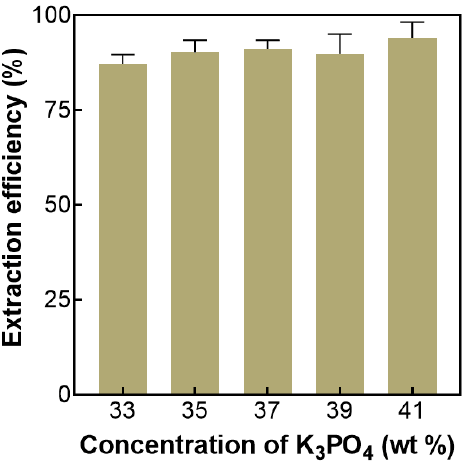
Figure 3. Effect of K 3 PO 4 concentration on the extraction efficiency of AMP. The fixed extraction condition: the extraction temperature was 15 °C.